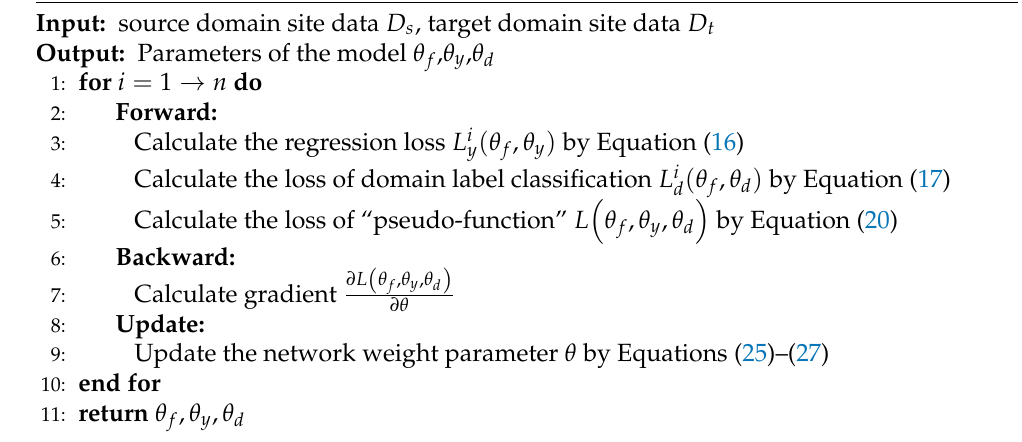
Algorithm 1 TL-DSTP-DANN model training process.